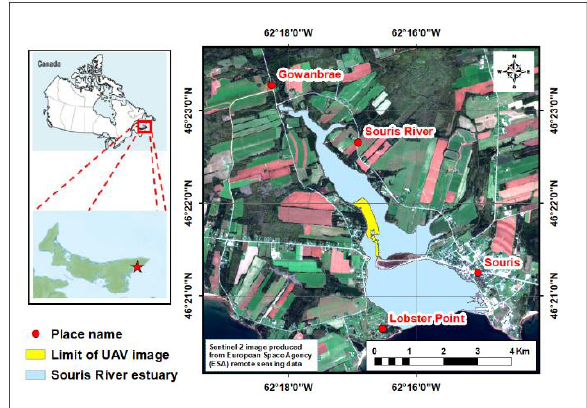
Figure 1. Location and limits of the study area imaged by the UAV over a Sentinel-2 image for the estuary of Souris